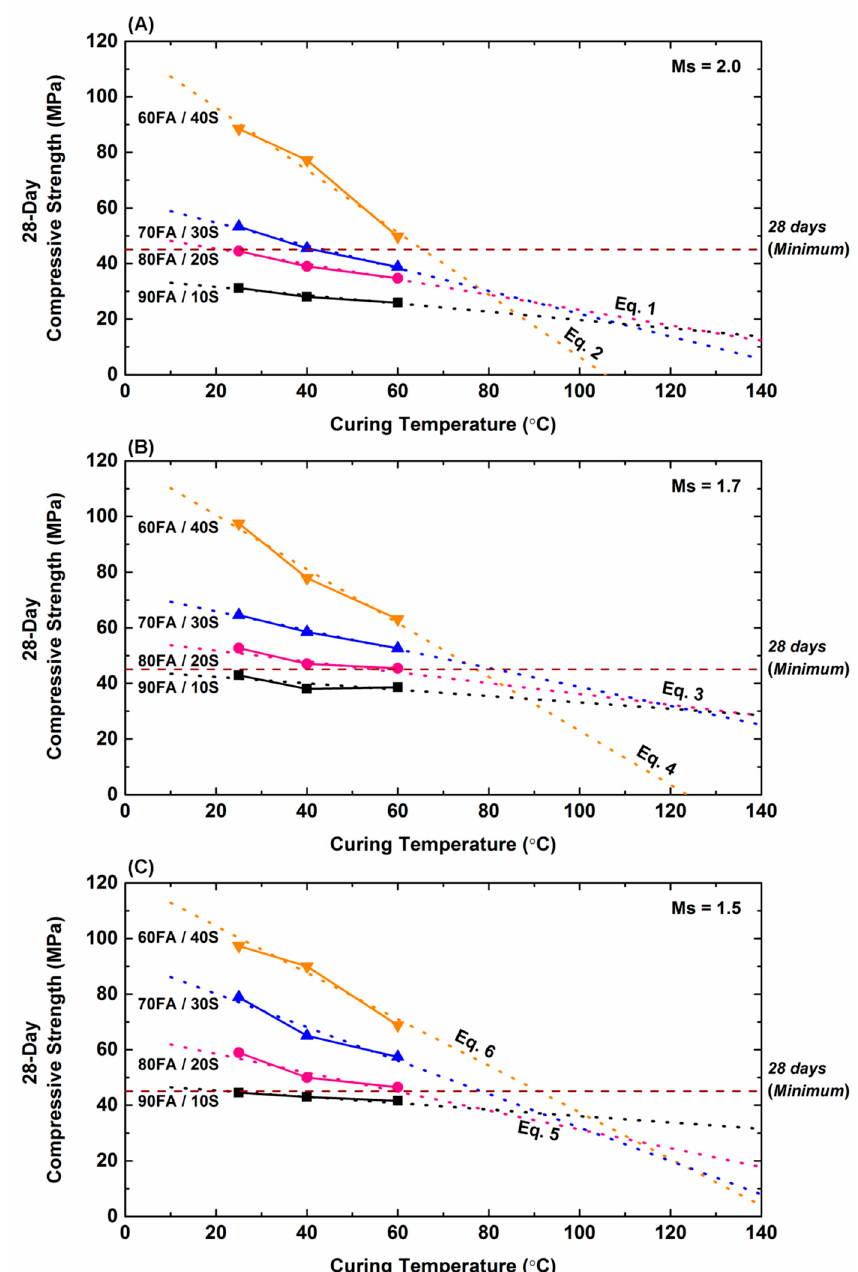
Figure 6. 28-day compressive strength (solid lines) and extrapolated values (dotted lines) as a function of curing temperature, slag content, and Ms (alkaline activator/SCM mass ratio = 0.5, water/binder ratio = 0.3) (Equations (Eq.) for these lines are shown in Table 4) ( A ) Ms 2.0, ( B ) Ms 1.7, ( C ) Ms 1.5.